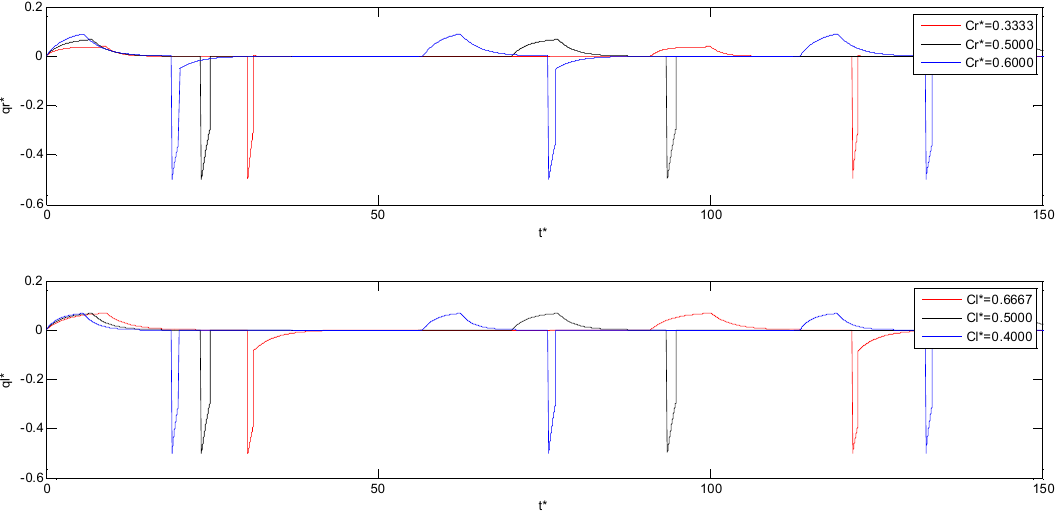
Figure 8. Influence of dimensionless compliance on dimensionless air mass flow of two lungs.